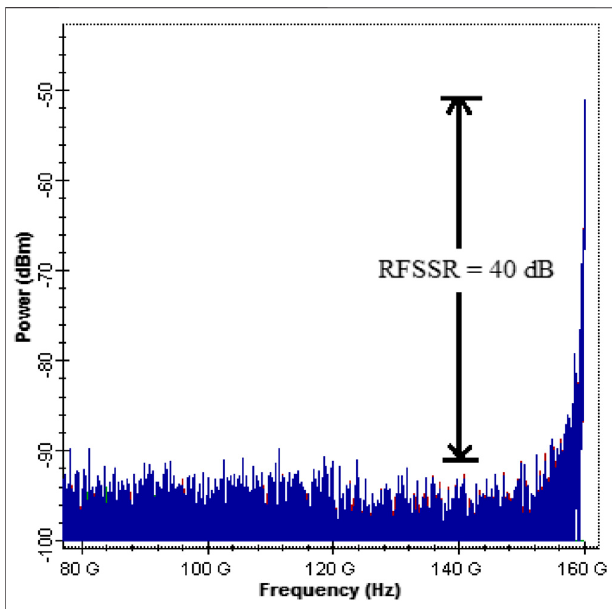
FIGURE 4 | RF spectrum of the photo-detected signal from the PIN photodiode.